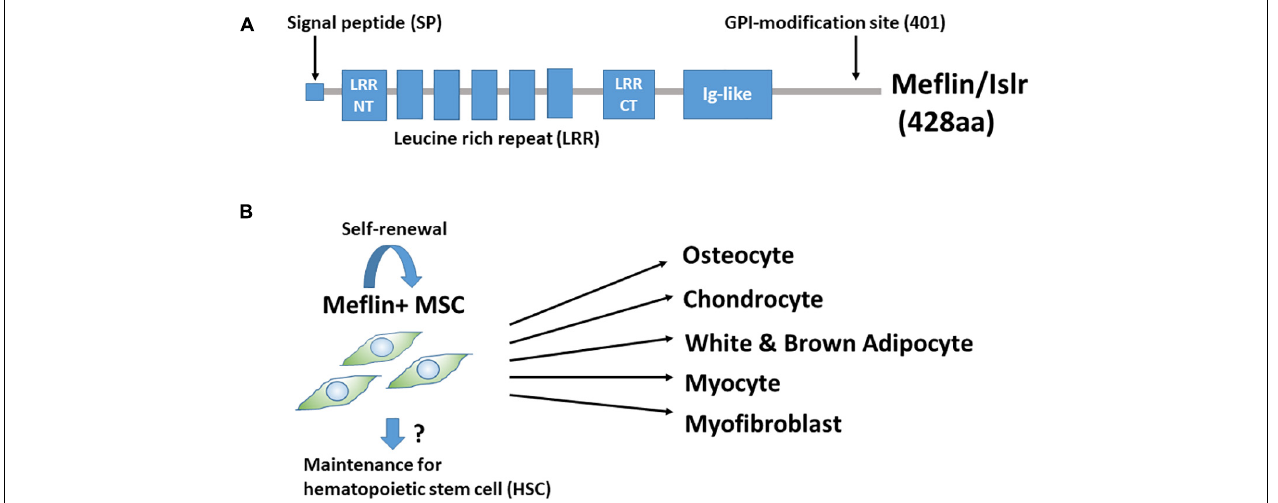
FIGURE 1 | (A) Structure of Meflin/Islr. It is a glycosylphosphatidylinositol-anchored membrane protein with five leucine-rich repeats (LRRs) flanked by cysteine-rich N- and C-terminal domains and an immunoglobulin (Ig)-like domain. (B) Meflin/Islr is an MSC marker. Meflin is highly expressed in undifferentiated MSCs, whereas its expression is downregulated upon MSC differentiation. A lineage trace experiment showed the possibility that Meflin + MSCs undergo self-renewal, although this has not yet been explicitly proven. Meflin + MSCs may also be involved in the maintenance of heamatopoietic stem cells in the bone